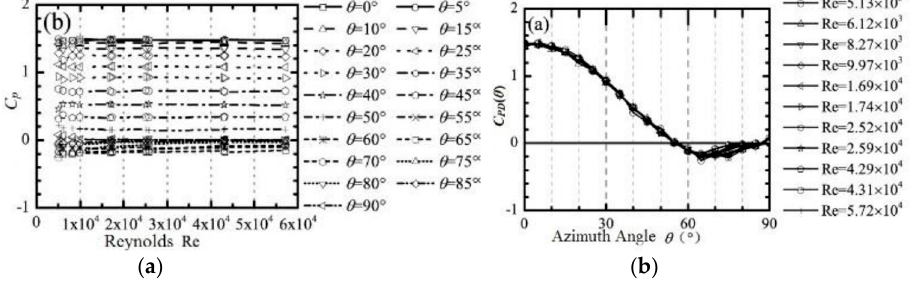
Figure 3. The measured pressure difference coefficients to ( a ) Reynolds numbers and ( b ) the azimuth angles.